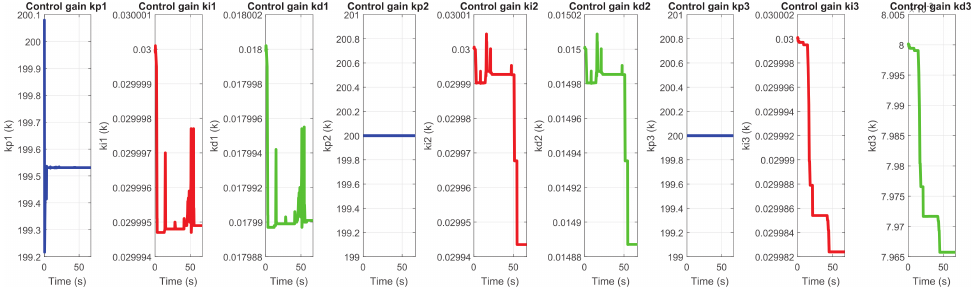
Figure 35. Self-tuning of gains k p , k d and k i in exercise 1.